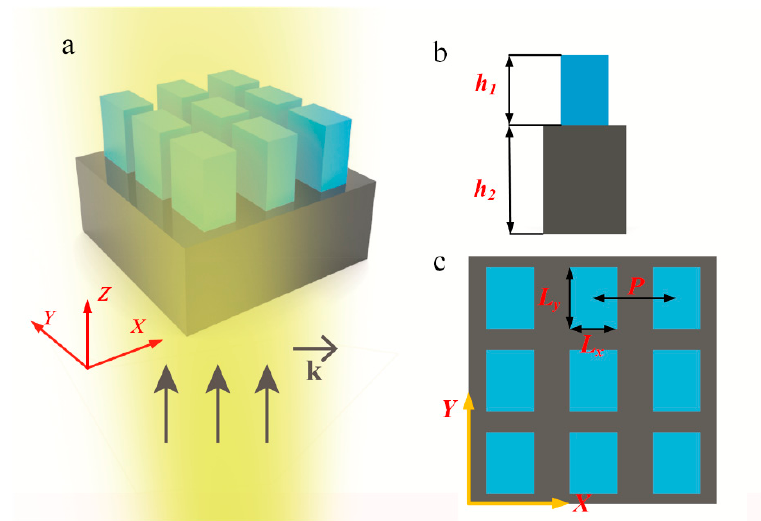
Figure 1. Geometry of the polarizer. ( a ) Sketch of arrays consisting of GaN rectangular posts and SiO 2 substrate. ( b ) Schematic of the unit cell with a scatterer height of h 1 and substrate height of h 2 . ( c ) Vertical view of arrays illustrating the period P and scatterer dimensions L x and L y .